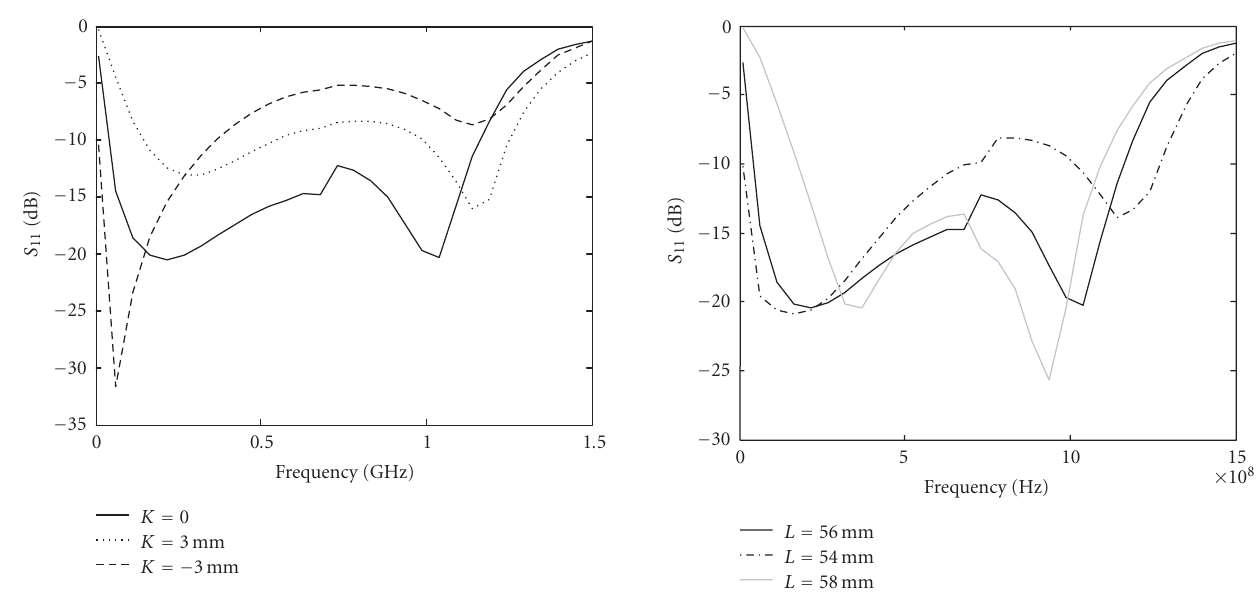
Figure 6: E ff ect of varying L to the antenna characteristic.